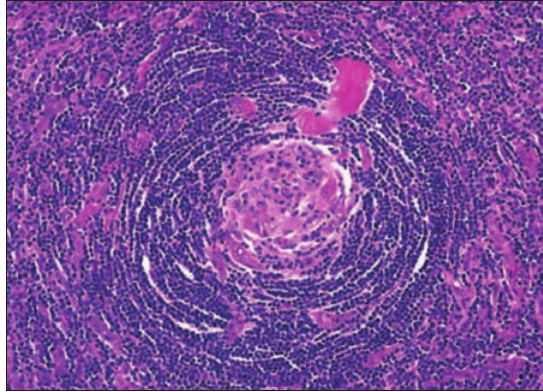
Fig. 1. Histology reveals small lymphocytes arranged in a concentric onion-skin pattern. These morphological features are characteristic of Castleman’s disease.